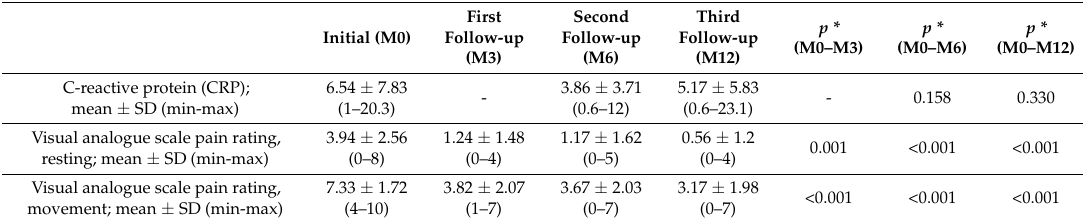
Table 1. Basic clinical comparison across the